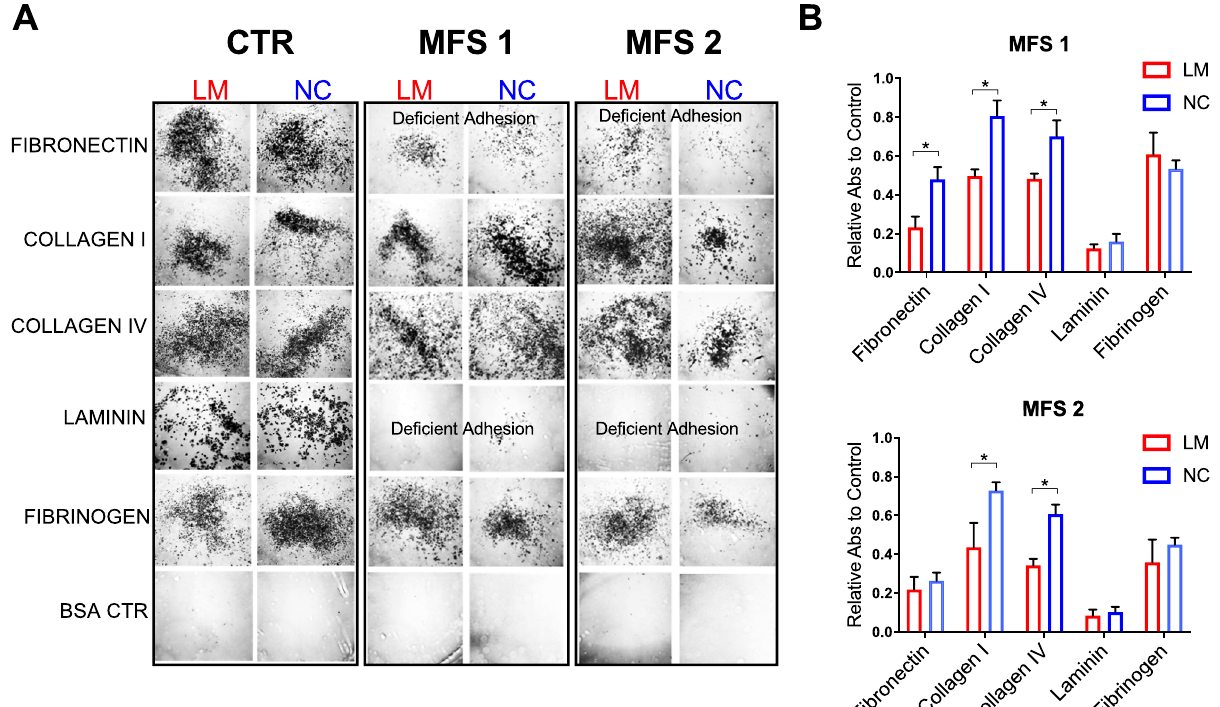
Figure 6. iPSC SMCs from MFS patients have cell adhesion deficiencies, in vitro. Cell staining and quantification of cell adhesion assay. Quantification results depict absorbance values for MFS iPSC SMCs normalized to donor control levels and plotted as average of two different experiments with three technical replicates. Normalized LM SMC absorbance was compared to NC SMCs. Groups were compared by non- parametric analysis (Mann–Whitney rank sum test). * P <